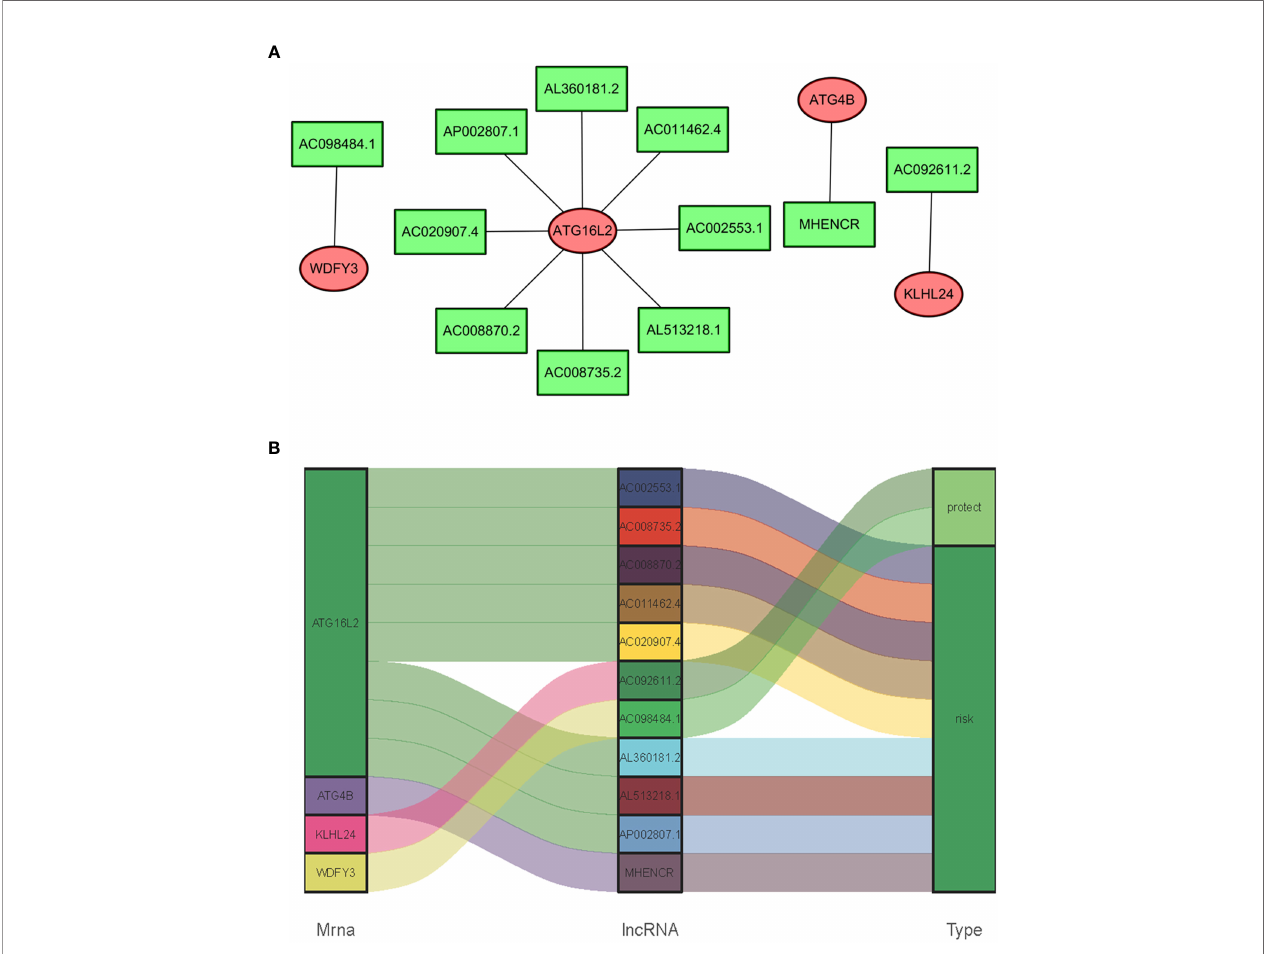
FIGURE 3 | The ROC curve and survival curve of the ARRS model. The receiver operating characteristic (ROC) curve of the ARRS model (A) . Kaplan ‐ Meier survival curve of OS in ccRCC patients from the high-risk group and the low-risk group. The results illustrated that the high-risk group has poor prognosis (B) .